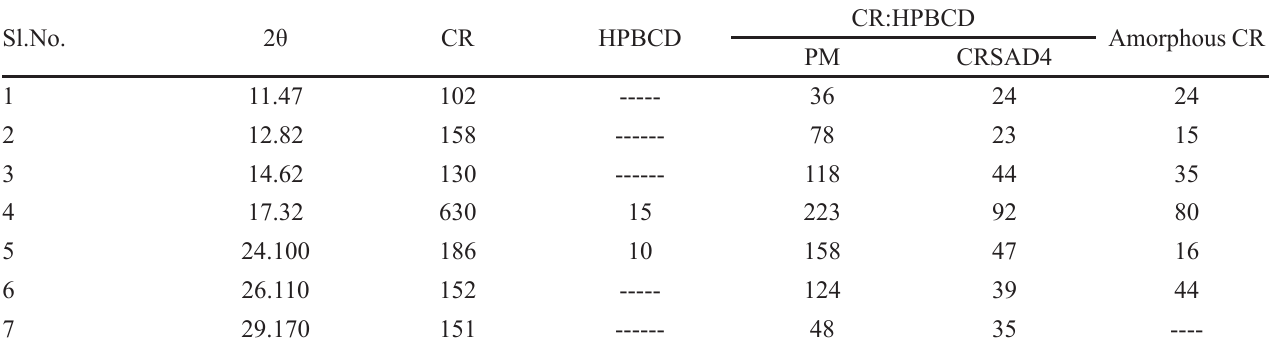
TABLE VII - Peak intensities of CR in XRD patterns of CR-HPBCD systems